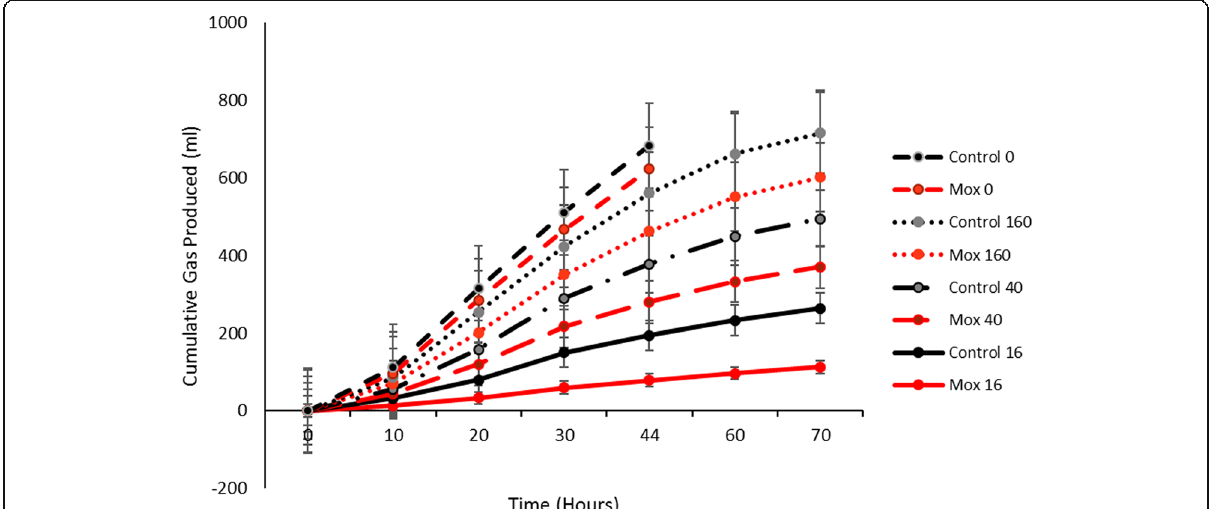
Fig. 2 Stacked cumulative gas production curves for hay for both moxidectin and control groups prior to and 16, 40 and 160 h after moxidectin treatment. *Indicate significant differences between time points within the moxidectin group ( p = 0.001). Error bars represent standard error